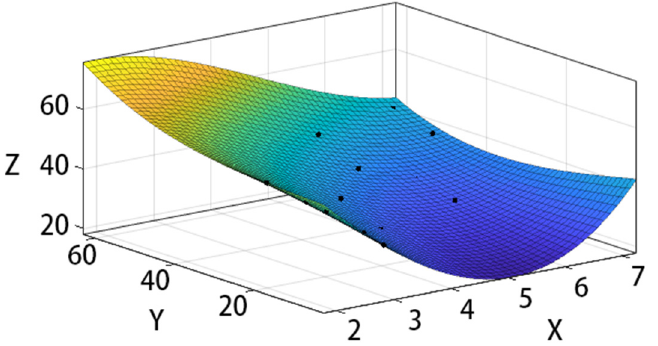
Figure 5. Bivariate fitting section plot: X is the object distance, Y is the value of zoom, and Z is the corresponding best focus. corresponding best